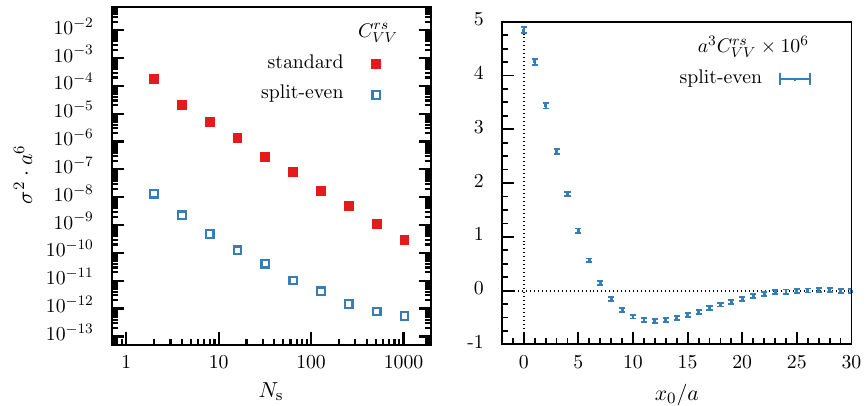
Fig. 6 Left: variance of the disconnected contribution in Eq. (7.1) with x 0 / a = 10 using the standard (red filled squares) and split-even estima- tor (blue open squares). The stochastic noise of the split-even estimator